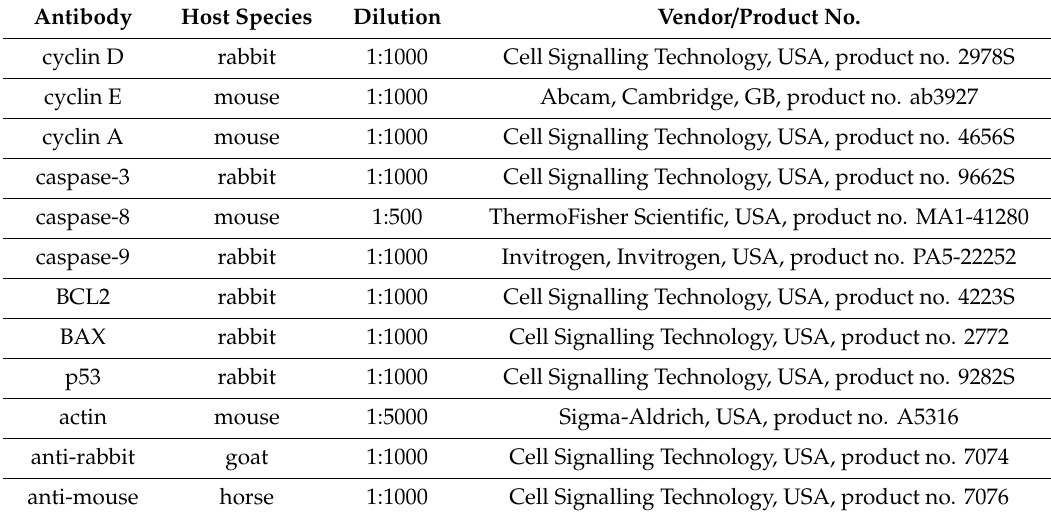
Table 1. Antibodies used in Western blot reaction.